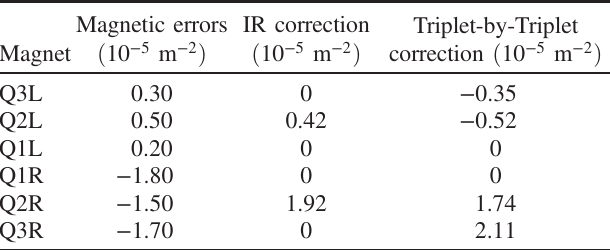
TABLE IV. Distribution of the magnetic errors in the IR1 quadrupoles used in the simulations shown in Sec. X. IR corrections (two correctors per IR) and triplet-by-triplet correc- tions (two correctors per triplet, four per IR) estimated for this distribution of errors are also shown.